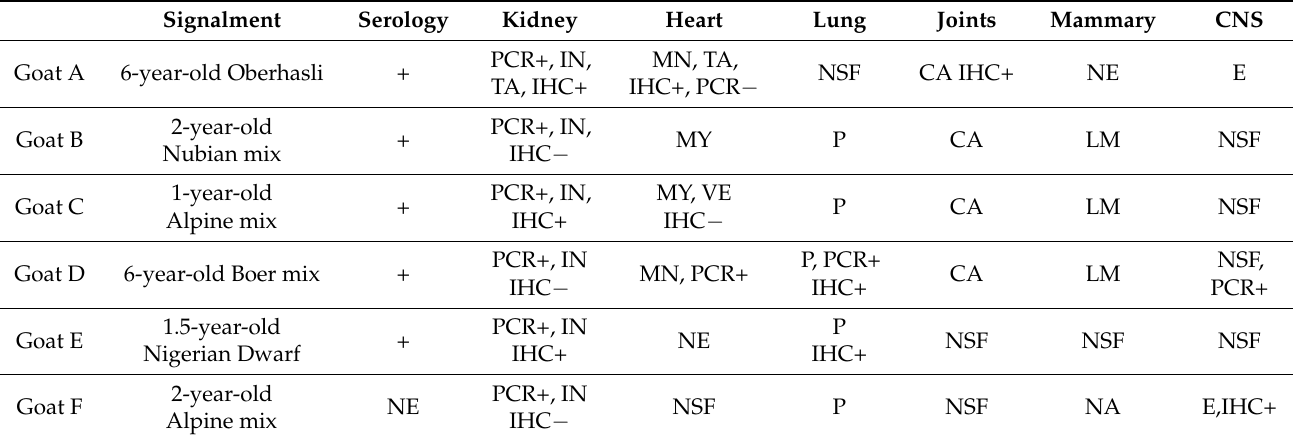
Table 1. Histological findings of goats A–E.